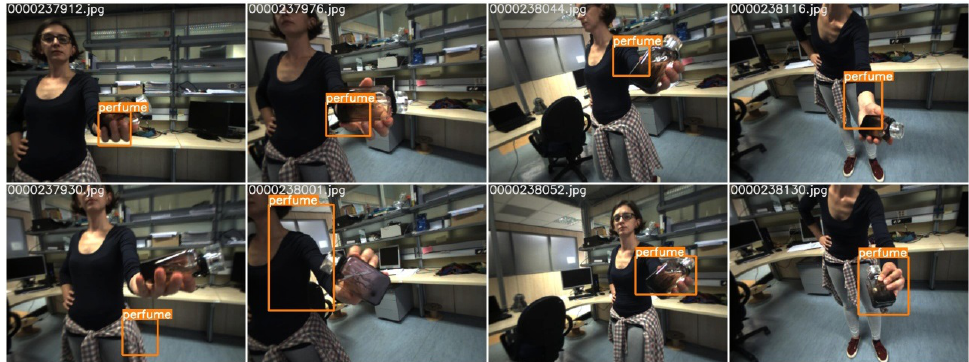
Figure 7. Example images from the iCubWorld dataset including the ground truth annotations that have been automatically generated from a human–robot interaction. In many cases the object has not or has only inaccurately been